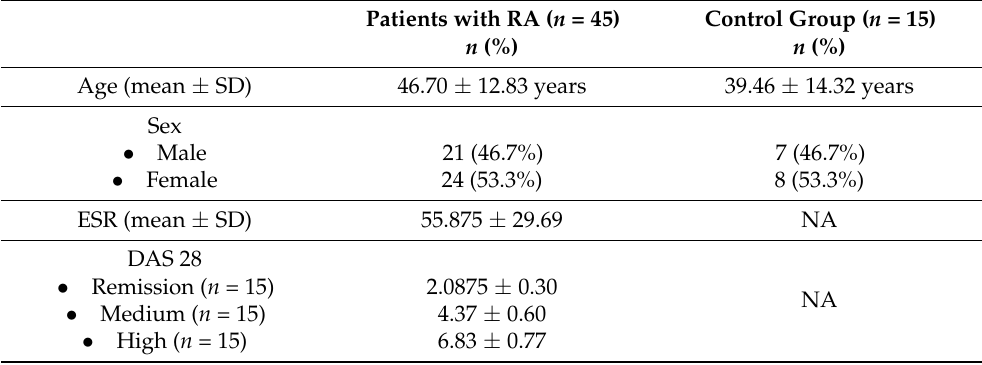
Table 1. Summary of demographic data and clinical characteristics of the participants